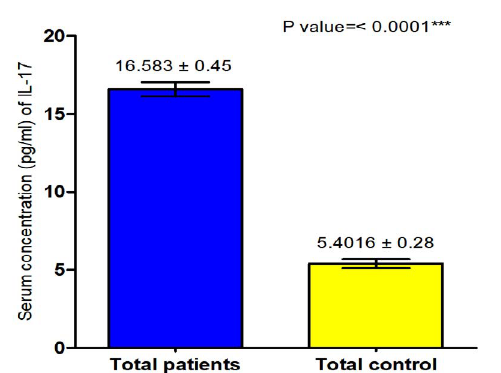
Fig. 7. Comparison between serum level of IL-17 in male and female with Sarcoptes scabiei and control group